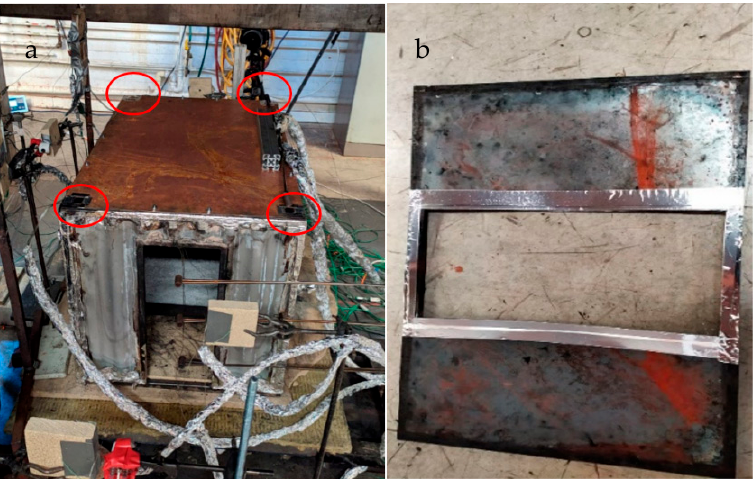
Figure 7. Roof of the compartment ( a ) with four corner horizontal openings and ( b ) one central slot horizontal opening.